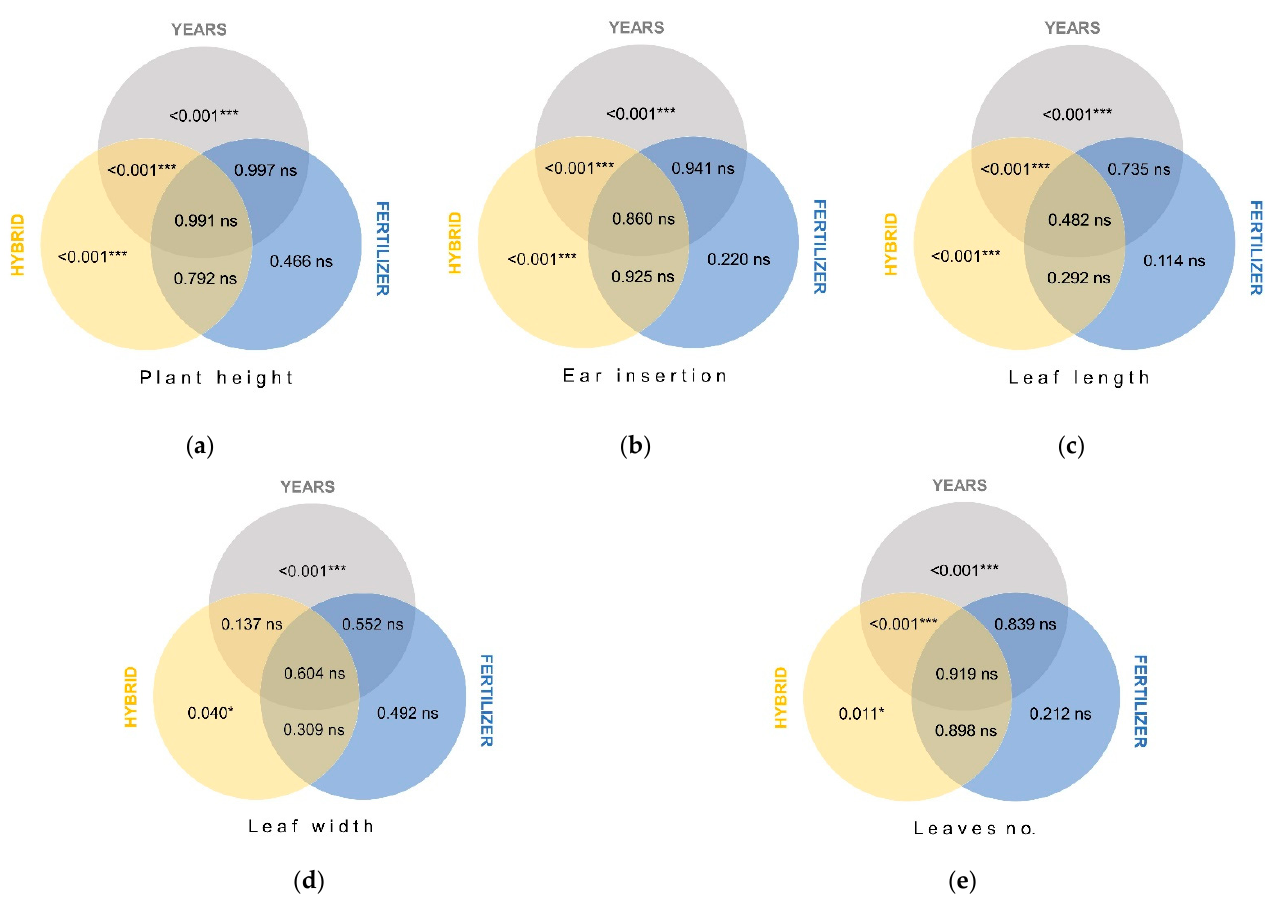
Figure 3. Venn diagram depicting the influence of experimental factors and their interaction on maize plant characteristics: ( a ) plant height; ( b ) ear insertion; ( c ) leaf length; ( d ) leaf width; ( e ) leaves number. Numbers represent p -values according to three-way ANOVA results; significance levels assigned p > 0.05 (ns), p < 0.05 (*), p < 0.001 (***).